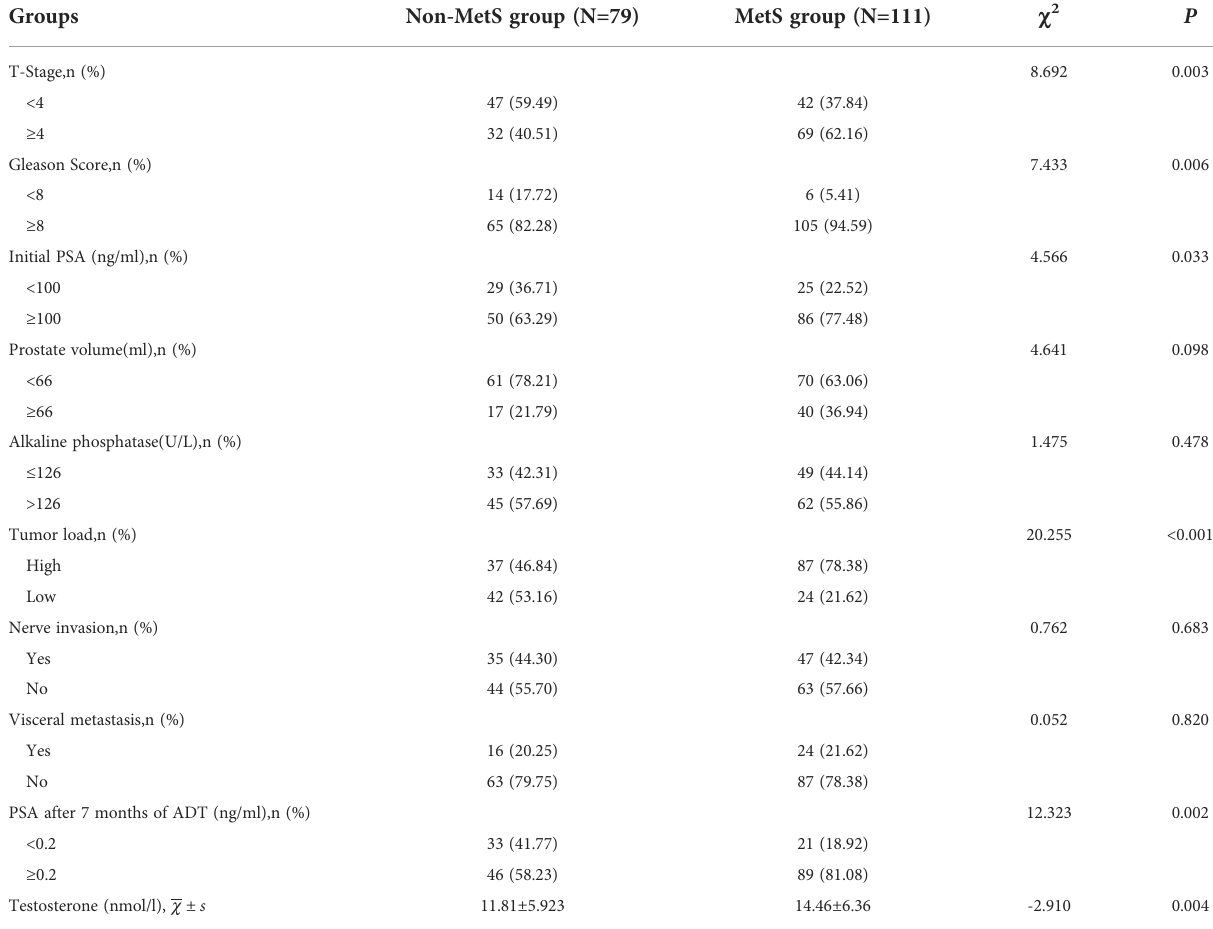
TABLE 2 Analysis of the clinical data between the Non-MetS group and MetS group. Groups